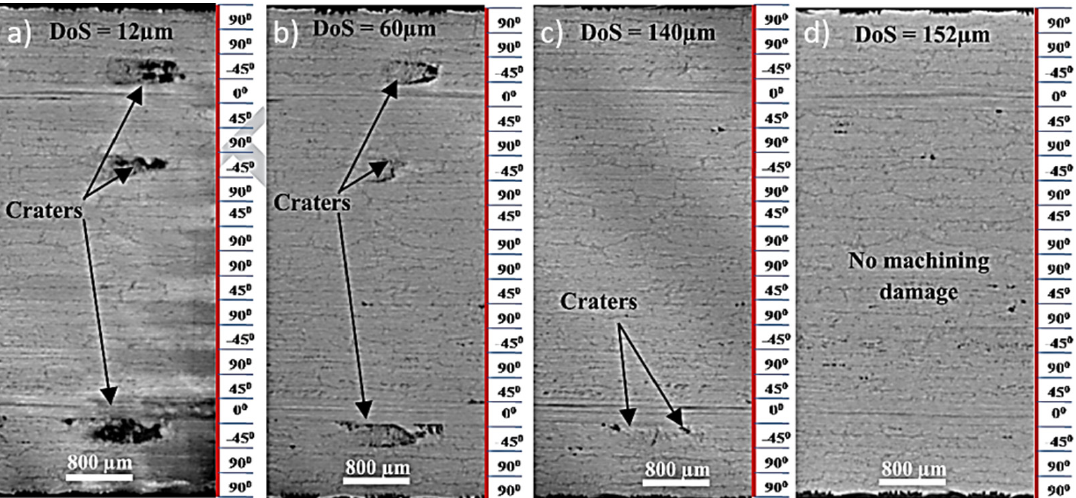
Figure 7. X-ray tomography images showing machining damage for cutting speed of 150 m/min and feed speed of 500 mm/min at cutting distance of 1.68 m with various depth of scanning of ( a ) 12 µm, ( b ) 60 µm, ( c ) 140 µm and ( d ) 152 µm [84].